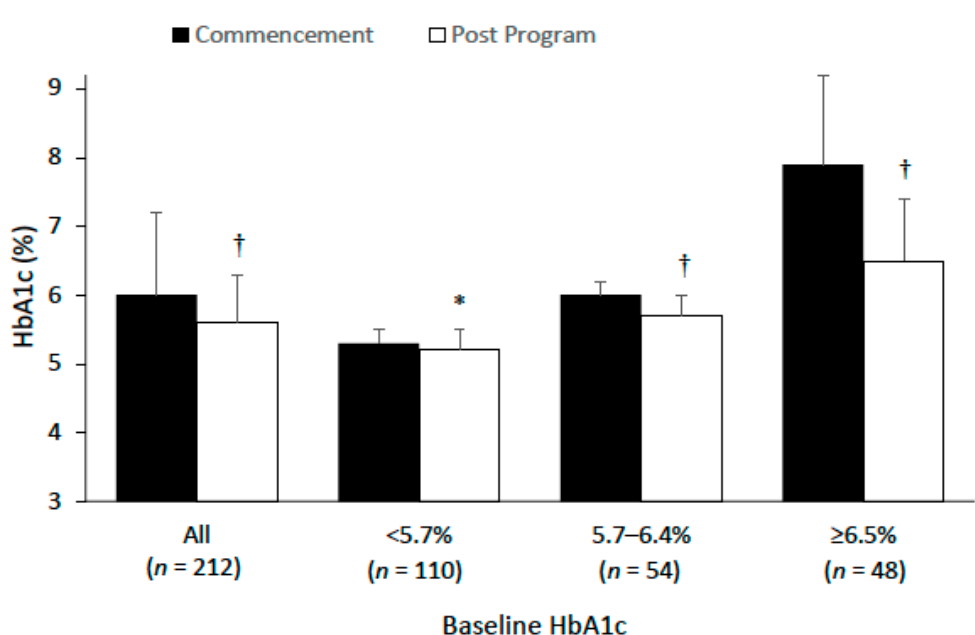
Figure 2. Haemoglobin A1c (HbA1c) before and at final visit for all members and for those with a baseline HbA1c of <5.7%, 5.7–6.4% and ≥ 6.5%. Values are mean ± standard deviation. * p < 0.05, † p < 0.001 significantly lower compared to commencement.